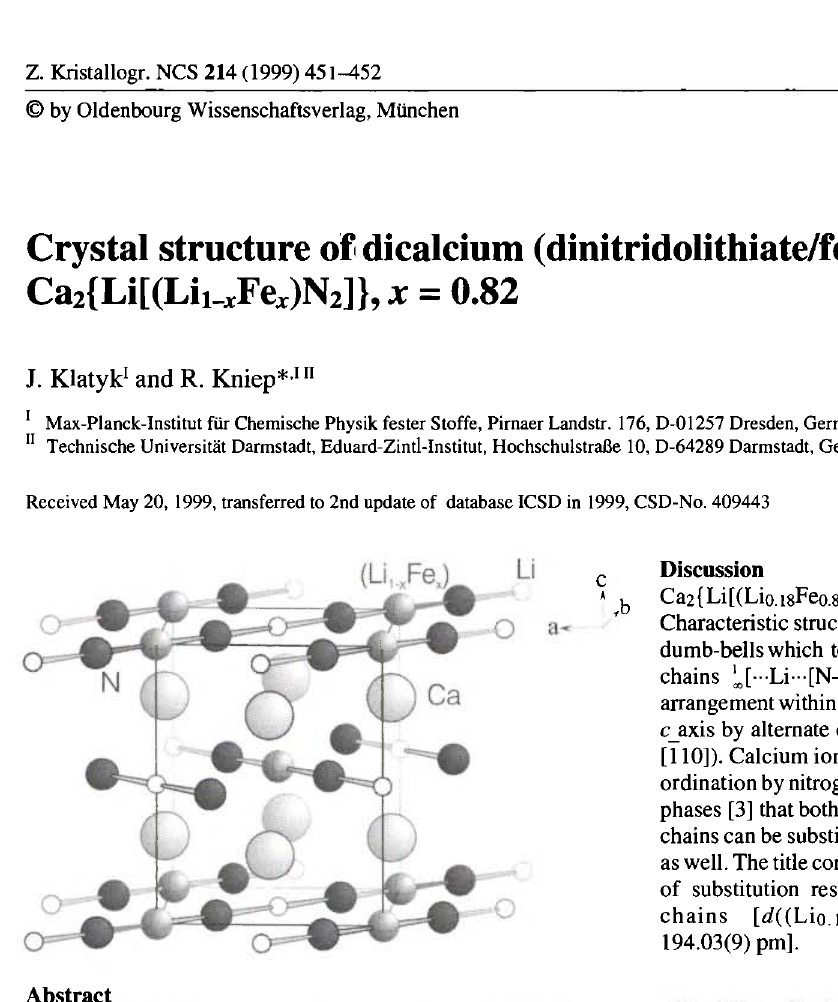
Table 1. Data collection and handling.